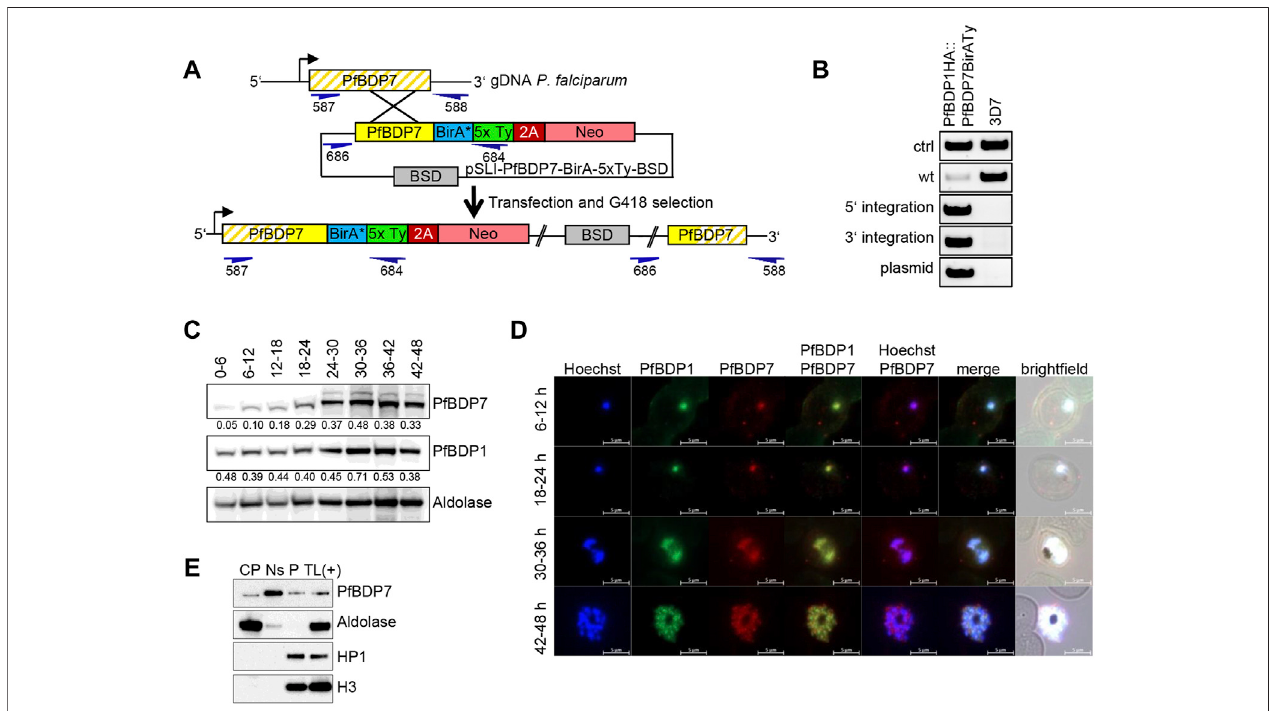
FIGURE2 | PfBDP7 expression during the P. falciparum asexual life cycle. (A) SchemeofSLI strategyfor modi fi cation ofthe PfBDP7 genomic locus byintegration of theBirA* biotin ligase and 5xTy sequences fused toa 2Askippeptideand theneomycin(Neo) selection cassette. Primer positions fordiagnostic PCR are indicated in dark blue, with numbers according to Supplementary Table S1 . (B) Diagnostic PCR screen for plasmid integration of the double transgenic parasite line PfBDP1HA:: PfBDP7BirATy(wt=wildtype,ctrl=control). (C) WesternblotanalysisofPfBDP7BirATyexpressionacrossthe48 hasexualparasitelifecyclerelativetoPfBDP1HA and aldolase as a loading control. Synchronized parasite lysates were prepared in 6 h intervals. Relative intensities compared to aldolase were determined by densitometry and are indicated underneath each blot. (D) Immuno fl uorescence analysis of PfBDP1HA::PfBDP7BirATy double transgenic parasites using antibodies detecting the HA tag fused to PfBDP1 or the Ty tag fused to PfBDP7. Hoechst 33342 was used for DNA staining. The parasite age post invasion of the parasites is indicated on the left (h). Scale bars, 5 µm. (E) Cellular fractionation of PfBDP7Ty parasites in cytoplasmic (CP), salt soluble nuclear (Ns) and pellet (P) fractions. A total lysate of PfBDP7Ty parasites as positive control [TL (+)] was analyzed alongside. The Western Blots were probed with antibodies detecting Ty, aldolase, HP1 (heterochromatin protein 1) or H3 (histone 3).